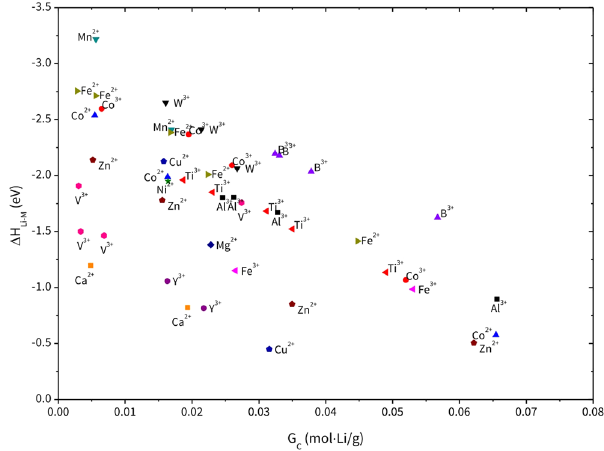
Figure 1. Overall design chart for the reaction between metal phosphate and Li 2